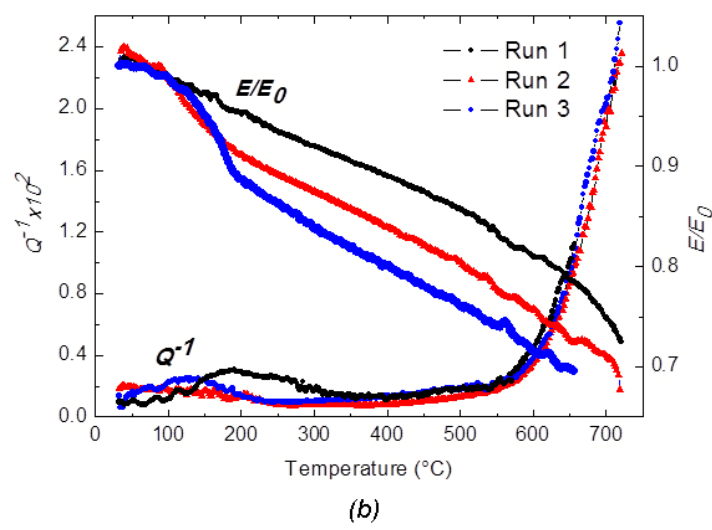
Figure 7. Fe ‐ Mo alloy produced via SPS from nano ‐ structured powders. Trends of Q − 1 and E/E 0 vs. temperature in successive test runs carried out on samples sintered at 840 °C ( a ) and 855 °C ( b